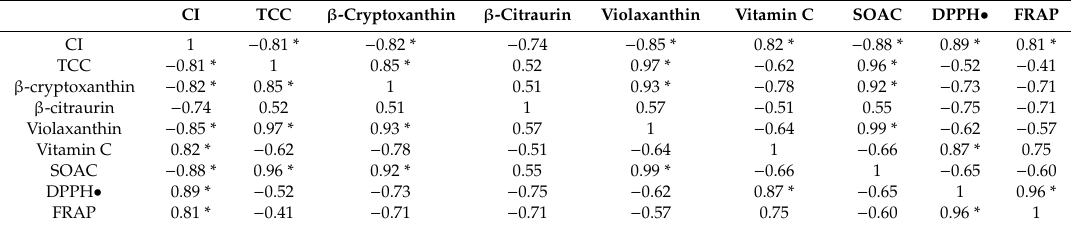
Table 4. Pearson’s correlation coe ffi cients ( r 2 ) among CI at the end of storage (8 weeks) and total carotenoid content (TCC), individual carotenoids ( β -cryptoxanthin, β -citraurin, and Violaxanthin), vitamin C and antioxidant capacity / activity (SOAC, DPPH • and FRAP) at harvest. CI TCC β -Cryptoxanthin β -Citraurin Violaxanthin Vitamin C SOAC DPPH